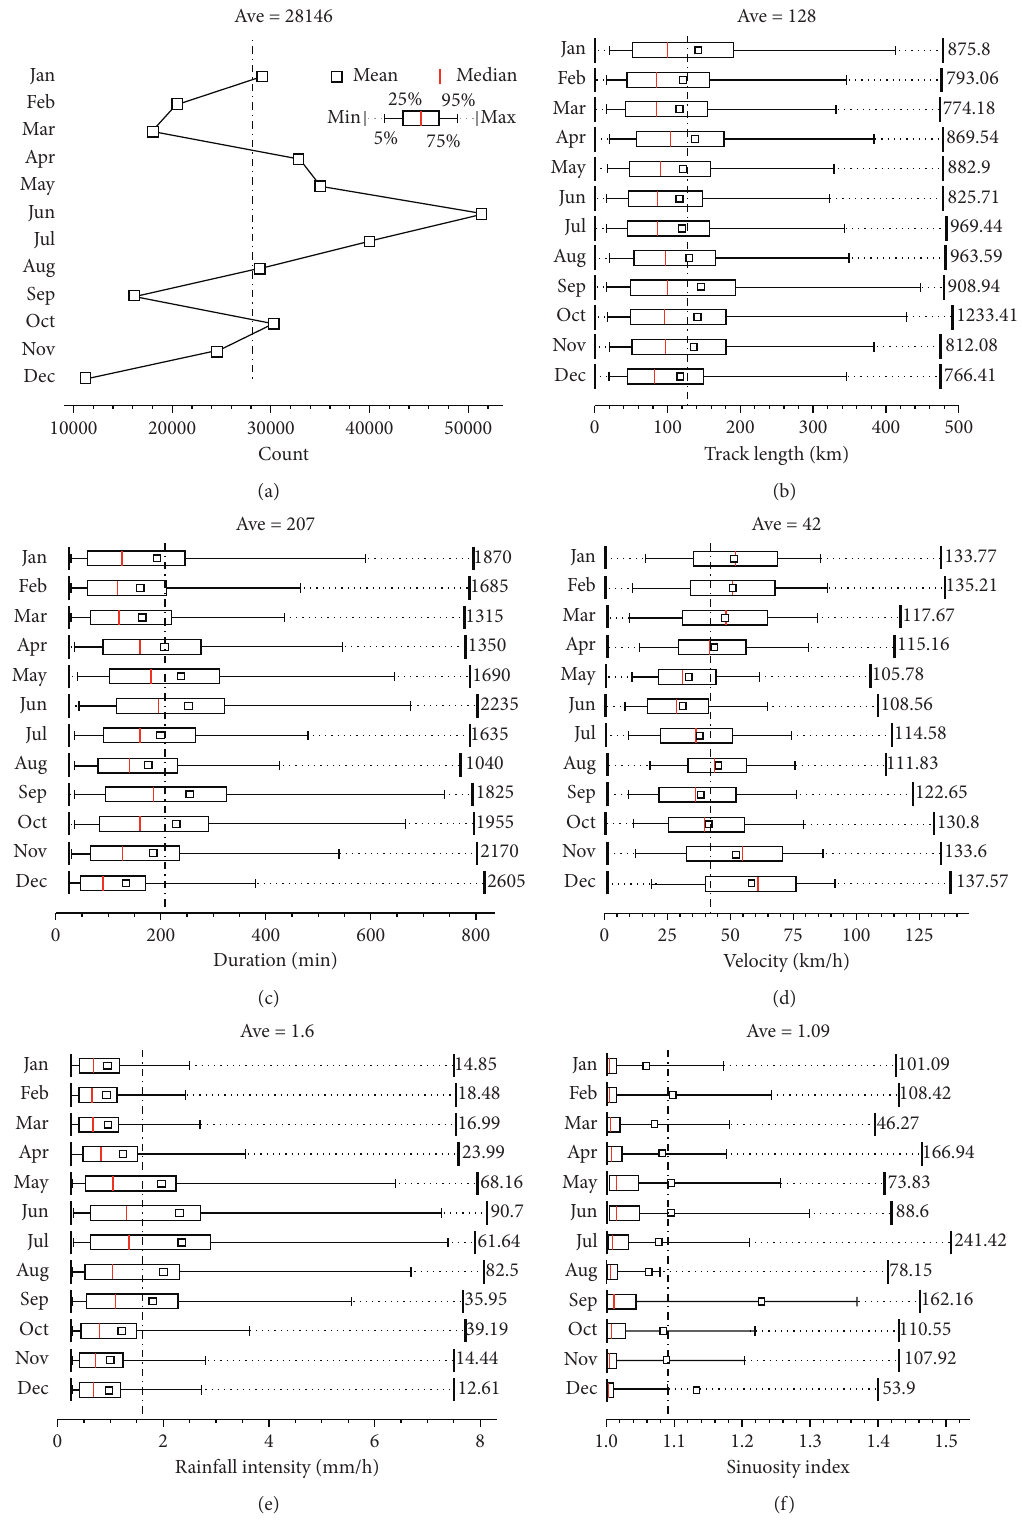
Figure 6: Statistical properties of detected tracks, organized by month: (a) number of detected tracks, (b) track length, (c) track duration (time elapsed from detection and loss of a feature), (d) feature velocity, (e) rainfall intensity of a detected feature, and (f) sinuosity index of a